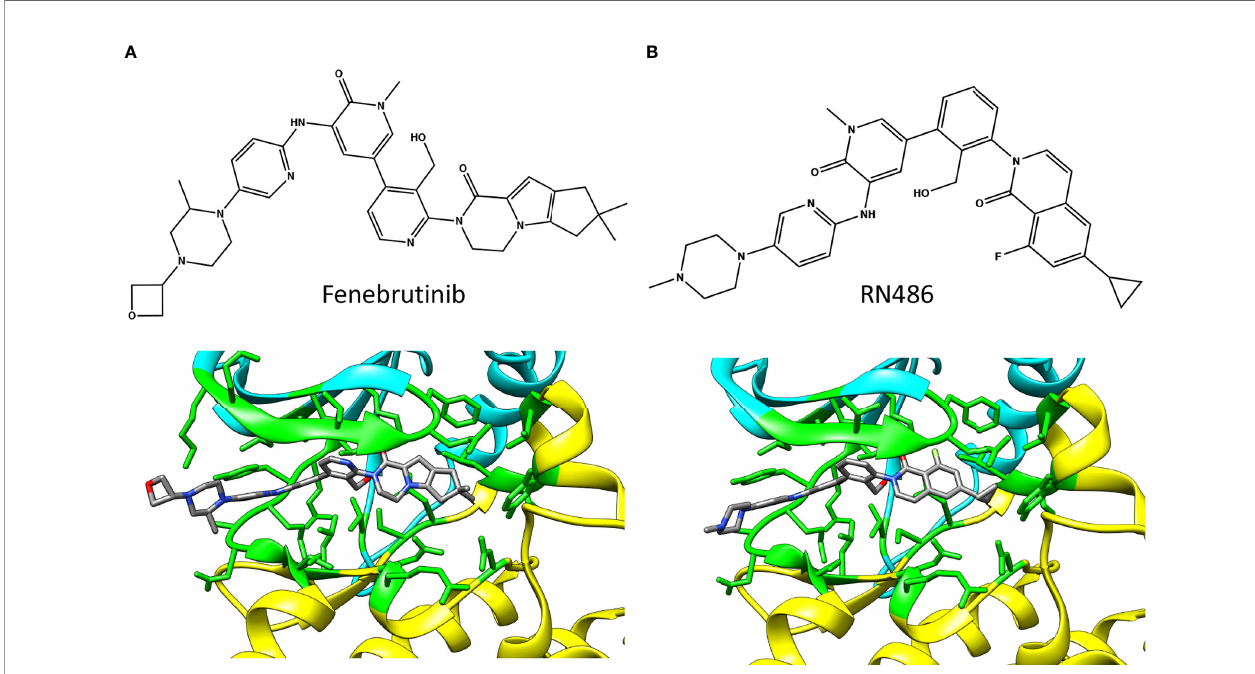
FIGURE 5 | Chemical structures and BTK binding of non-covalent inhibitors (A) fenebrutinib (5v fi ) and (B) RN486 (5p9g). Residues within 5 Å distance from inhibitor are shown in green. Atoms in the inhibitors are colored based on the elements, carbon gray, nitrogen blue, oxygen red, and fl uorine pale green. The structures have the same pose as in Figure 2C